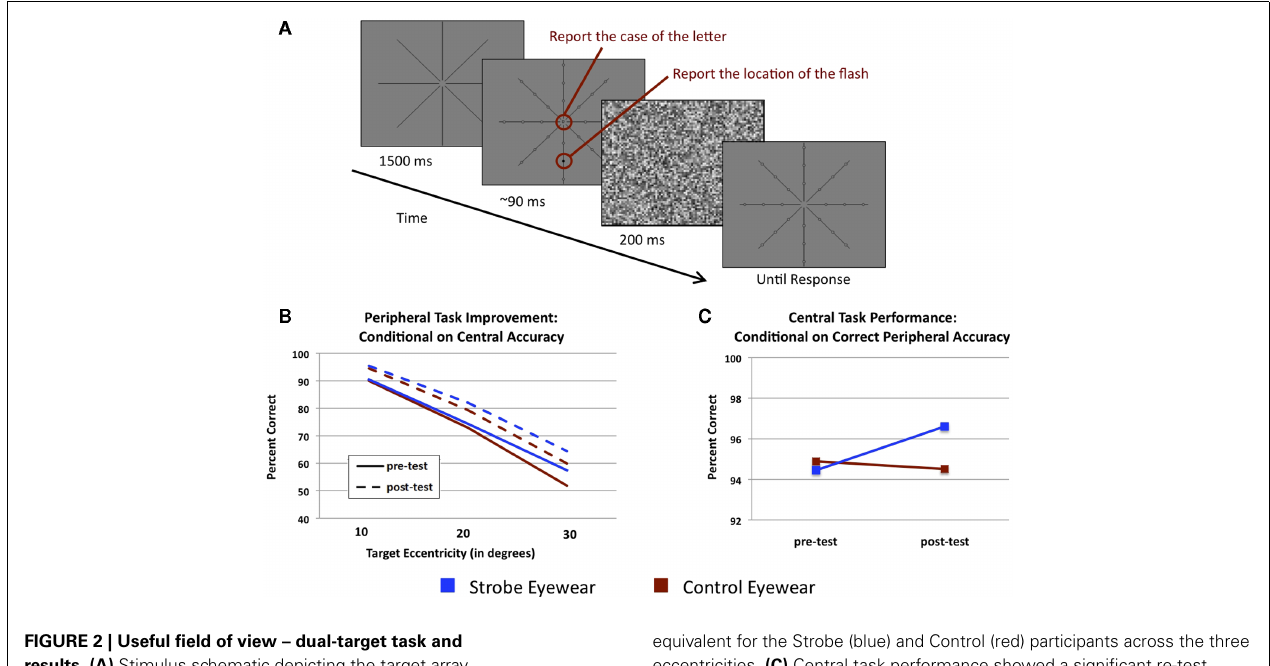
FIGURE 2 | Useful field of view – dual-target task and results. (A) Stimulus schematic depicting the target array, the central letter task and peripheral flash detection task, and the mask. (B) Pre-test (solid) to post-test (dashed) differences were